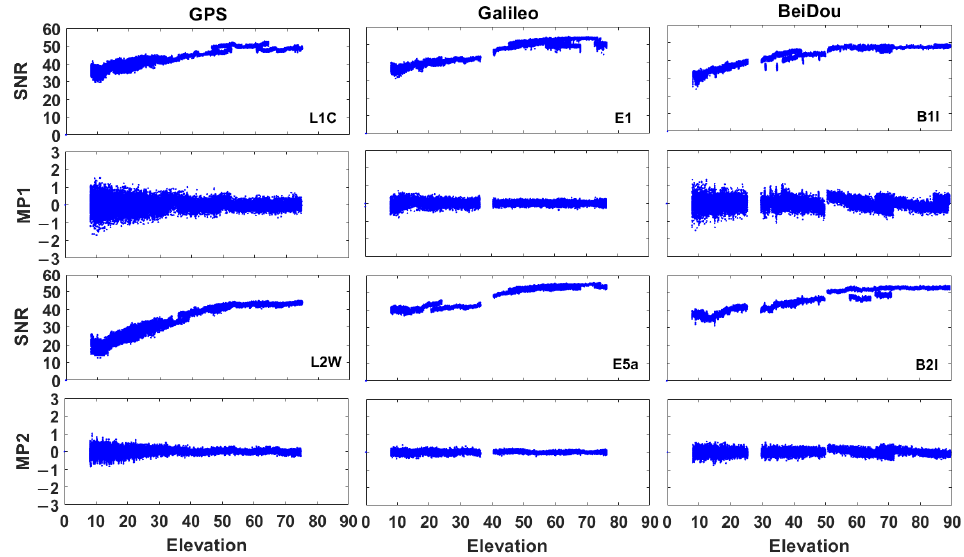
Figure 14. SNR (expressed as dB-Hz) and pseudorange multipath (MP1 and MP2, expressed as metres, the elevation was expressed in degrees) at mobile receiver by using GPS, Galileo and BeiDou satellites.